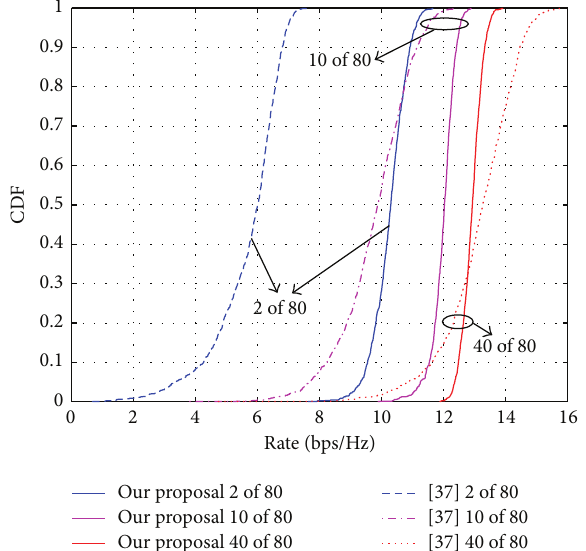
Figure 9: 𝑀 𝑡 = 80 , comparison of system capability versus